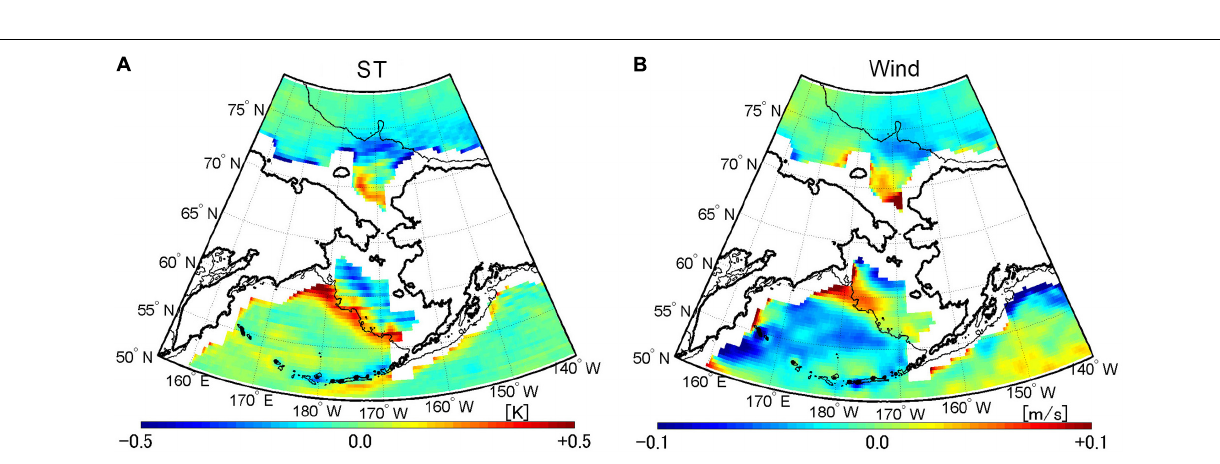
of sensible and latent heat fluxes in 72–77 ◦ N, corresponding to the northward shift of marginal ice zone, mean that the warmed sea surface strengthened turbulent heat transfer to